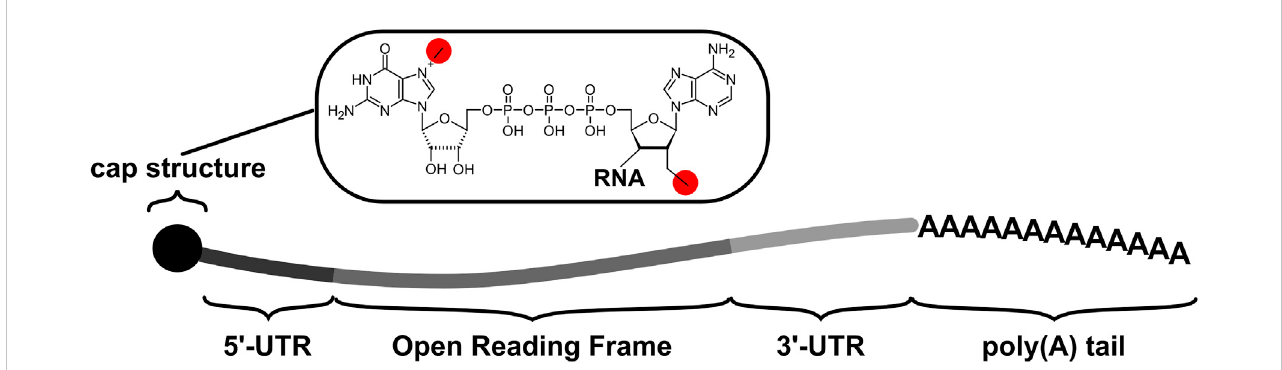
FIGURE 1 TheprincipalcomponentsofnativetranscriptsaswellasIVTmRNAscompriseuntranslatedregions(UTRs)which fl anktheprotein-codingOpenReading Frame or ORF. Cap structures are introduced co-transcriptionally in vivo and may be introduced co- or post-transcriptionally in vitro . The poly(A) tail is added post-transcriptionally in vivo , and may be added as part of the transcribed sequence or post-transcriptionally in vitro . The chemical detail illustrates the cap1 structure which is characterized by the two methyl group highlighted in red (alternative cap structures differ in the number and locations of the methyl groups).